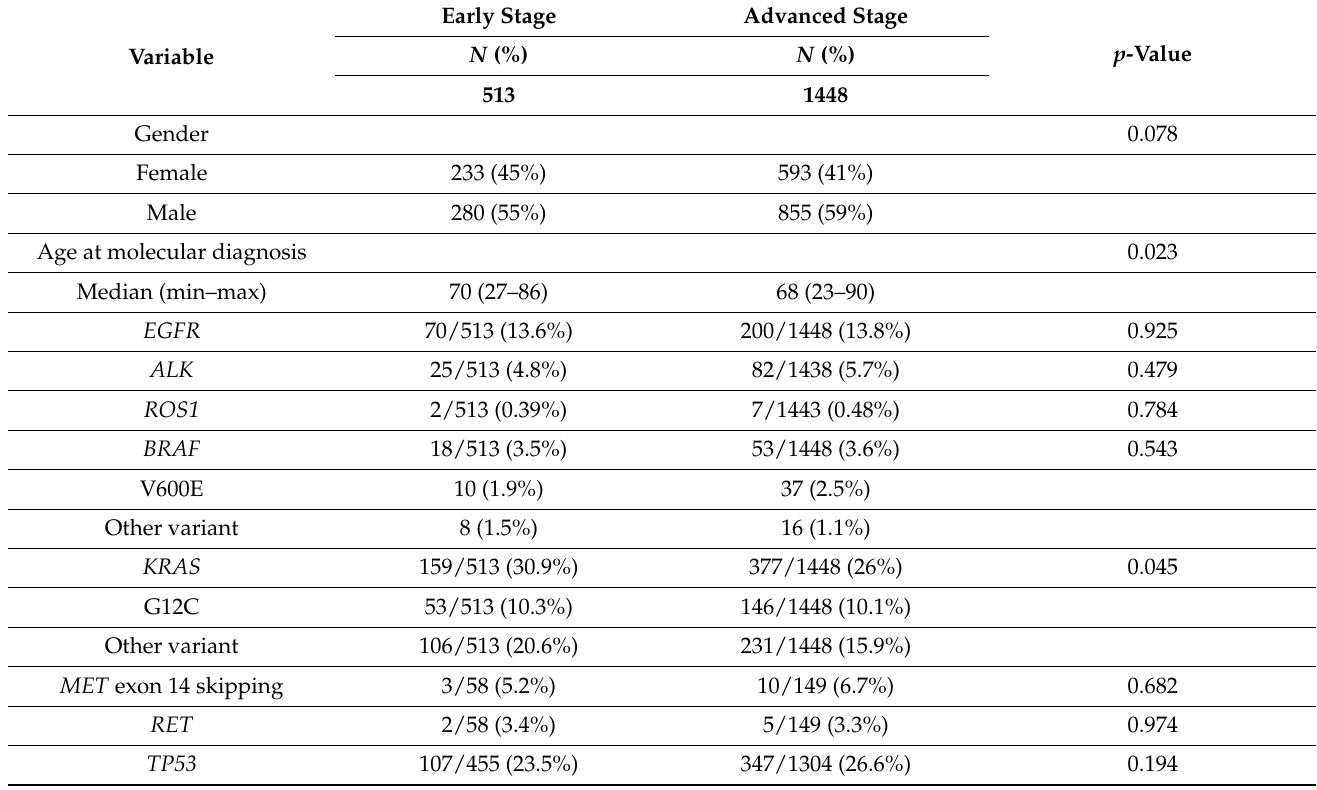
Table 2. Patients’ characteristics according to clinical